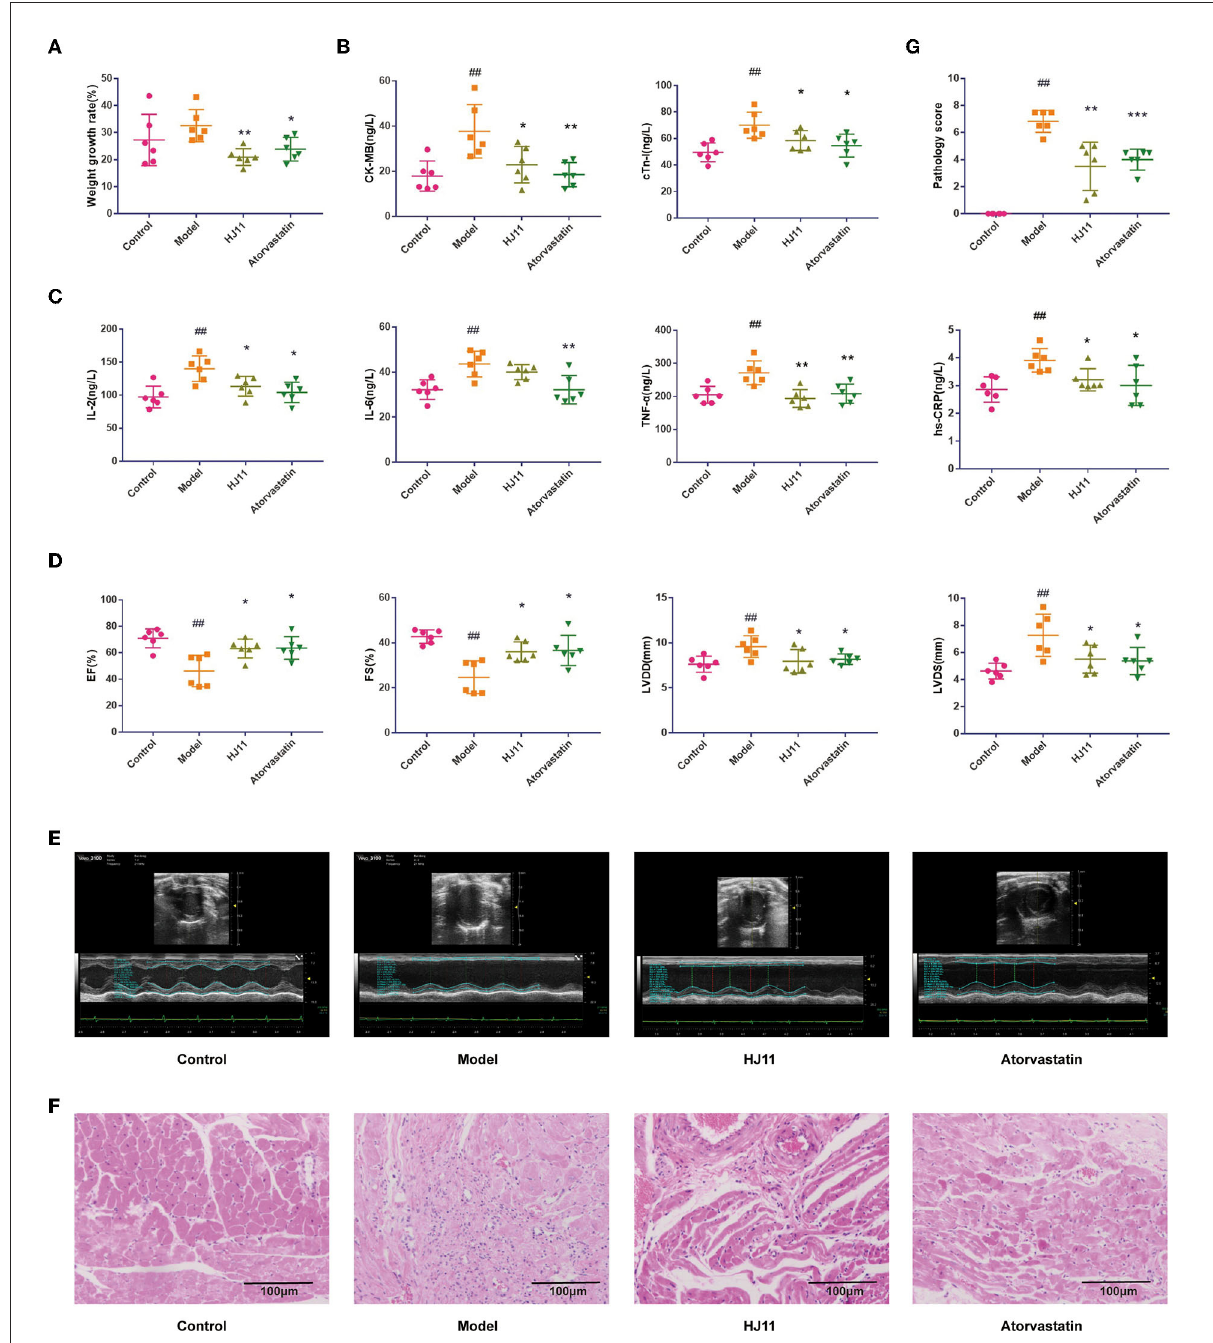
FIGURE3 Effects of HJ11 on ACS model rats. (A) Changes in body weight in different groups. (B) Cardiac enzyme detection in different groups. (C) Inflammatory factor detection in different groups. (D) Echocardiogram data. (E) Echocardiogram images. (F) HE staining of heart tissue. (G) Pathological scores of heart tissue. ## P < 0.01 compared with the control group; * P < 0.05, ** P < 0.01, *** P < 0.001 compared with the model